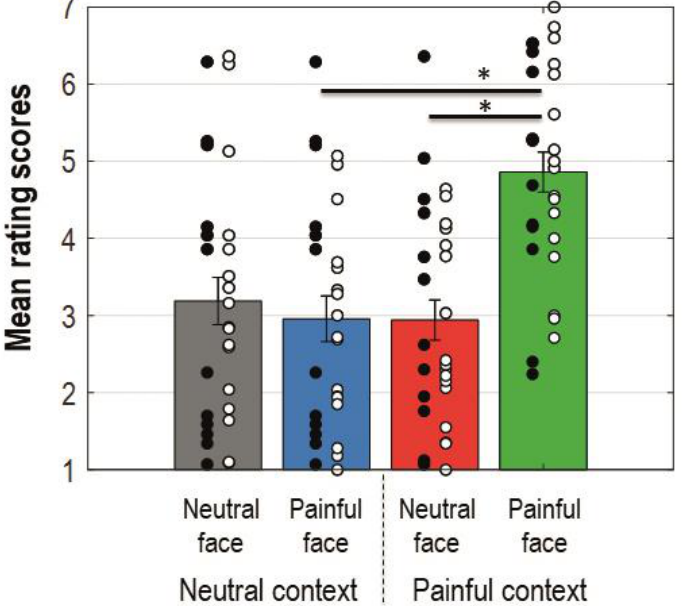
Figure 2. Bar-graphs displaying mean rating scores for each condition collapsed on group dimension. Error bars represent standard errors; black dots represent single patients; white dots represent single control participants. Colours of the bars match colours of the ERP waveforms for corresponding conditions. An asterisk indicates a statistically significant comparison. 3.5. ERP Responses in the Empathy Task Figure 3 shows the grand averages of the ERP components time-locked to the onset of the face as a function of the context recorded at the sites that formed a cluster. Each experimental condition is presented superimposed with the ERPs elicited in the neutral condition (i.e., neutral context and neutral facial expression) from the left to the right (i.e., left panel: neutral context and painful facial expression; middle panel: painful context and neutral facial expression; right panel: painful context and painful facial expression). The two topographies for each graph represent the scalp activity in the early and late time- windows. Panels A, B, and C show results from the patients with SBMA, panels D, E, and F show the results from the controls and panels G, H, and I show the differential ERPs computed as the difference of each experimental condition minus the neutral condition for the SBMA patients and the controls.